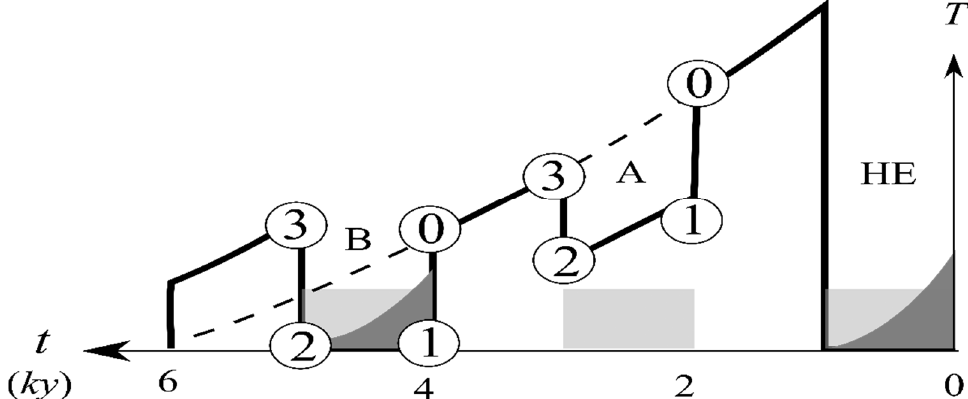
Figure 8. The anatomy (in SST) of the DO cycles corresponding to that shown in Figure 7 when the freshwater flux is a square-wave of a 2 ky period (light shading). Type B’s stadial has reached freezing-point to cause formation of the sea-ice (dark shading), resulting in a greater rebound of the ensuing interstadial, but otherwise both the S/IS trend as the H-cooling curve (dashed) to exhibit the hierarchical Bond cycle.